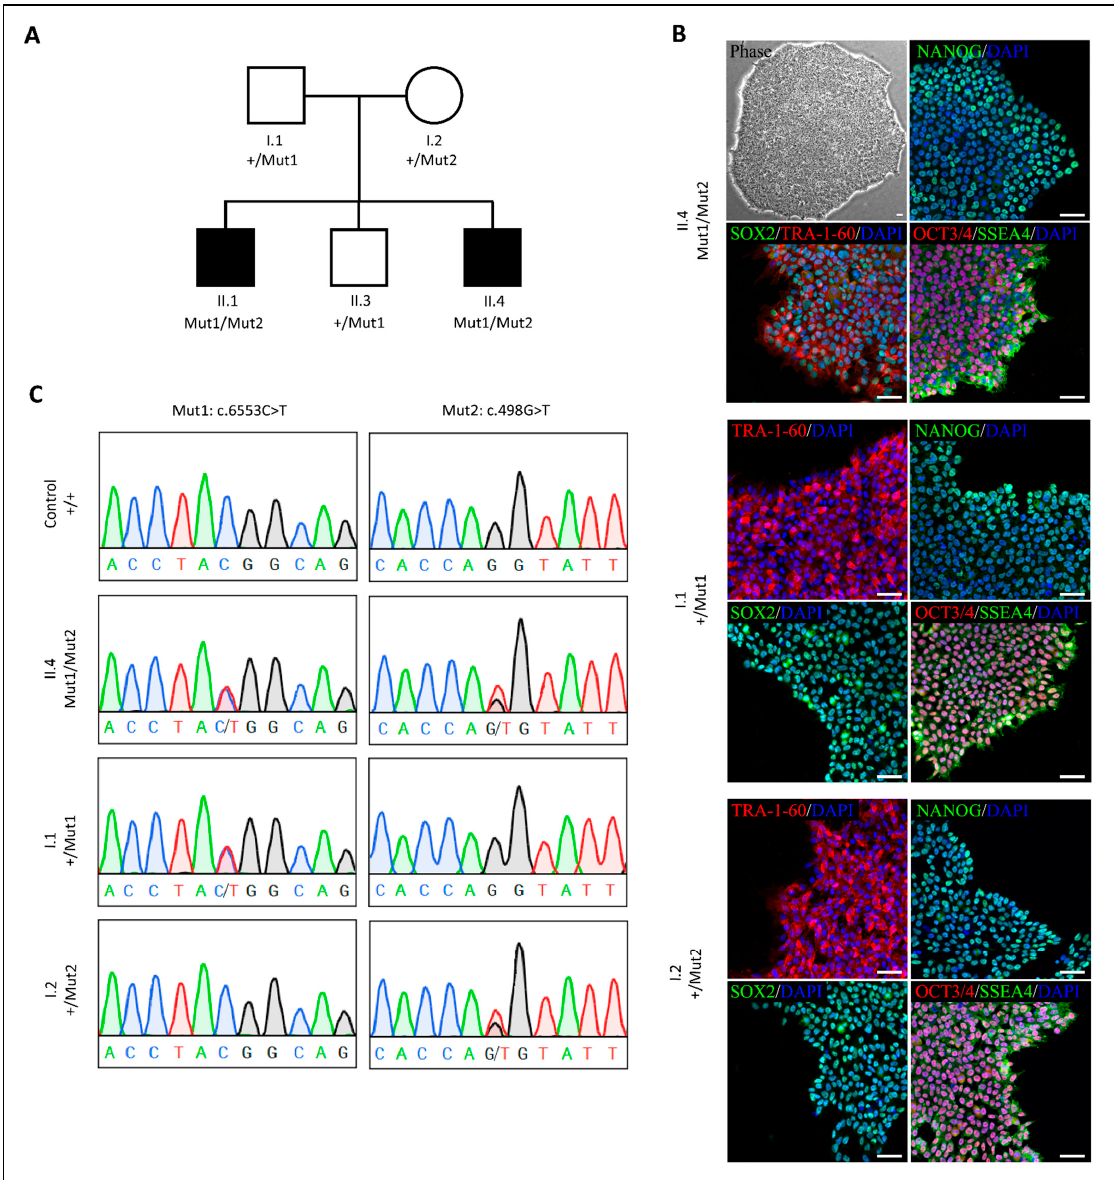
Figure 1. Genotyping and pluripotency characterization of family-derived hiPSCs. ( A ) Family pedigree. Affected individuals are represented by filled black symbols. The (+) sign indicates the reference allele, Mut1 indicates mutation c.6553C>T, and Mut2 indicates mutation c.498G>T. According to an autosomal recessive inheritance pattern, each healthy parent is heterozygous for one of the two identified gene variants. The healthy sibling is a carrier of only one SZT2 variant (the paternal one), while the affected individuals carry both Mut1 and Mut2. Adapted with permission from Ref. [8]. ( B ) Representative phase microscopy picture of a hiPSC colony from the patient’s line. Immunofluorescence staining of the three cell lines from the family showing the nuclear immunoreactive signal for OCT3/4 (red), SOX2 (green), NANOG (green) and surface localization for SSEA4 (green), TRA-1-60 (red) pluripotency markers. Scale bar 50 μ m. ( C ) Sanger sequencing